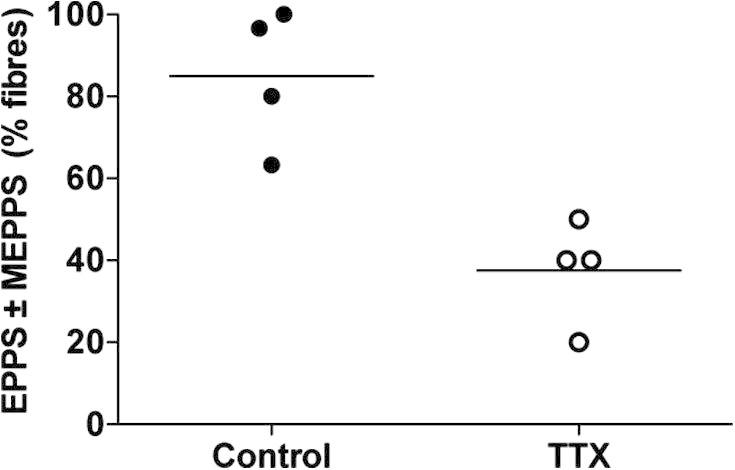
Effect of TTX block on loss of innervation, 12 h after sectioning the sciatic nerve in wild-type mice. Those receiving a preconditioned 7 days of sciatic nerve block showed significantly fewer innervated or responsive NMJs than unblocked controls (P < 0.01; t-test).